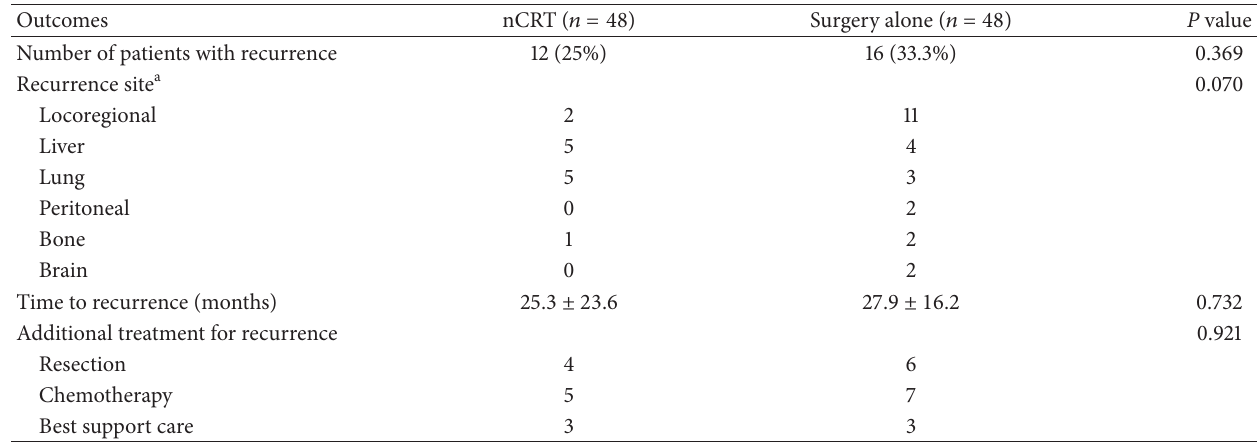
Table 4: Recurrence patterns between nCRT and surgery-alone